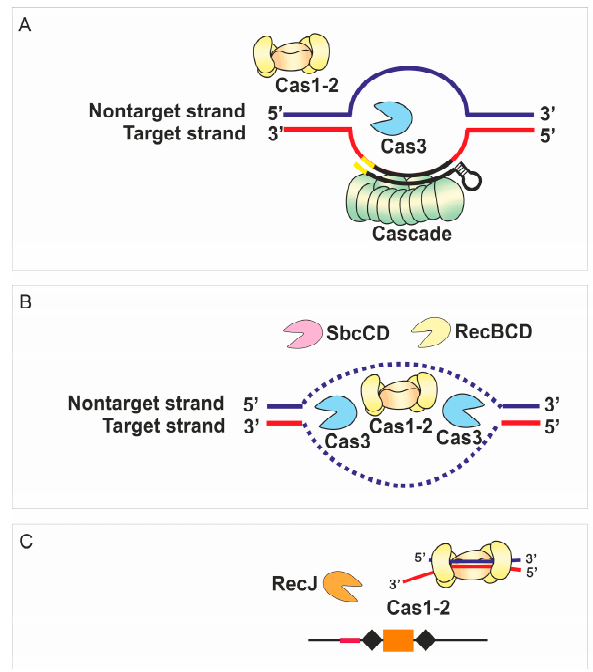
Figure 5. A possible mechanism of primed adaptation by the E. coli type I-E CRISPR-Cas system at conditions of self-targeting. ( A ) Target recognition and R-loop formation by the Cascade complex recruits the Cas3 nuclease-helicase required for CRISPR interference/target degradation. ( B ) The Cas1-Cas2 adaptation complex uses the products of DNA degradation to generate prespacers. Additional protein complexes (RecBCD, SbcCD) affect the pool of DNA intermediates available for Cas1-Cas2. ( C ) The Cas1-Cas2 adaptation complex interacts with prespacer fragments and channels them for insertion into the CRISPR array. RecJ finetunes the AAG specificity and precision of the adaptation complex at a later stage.